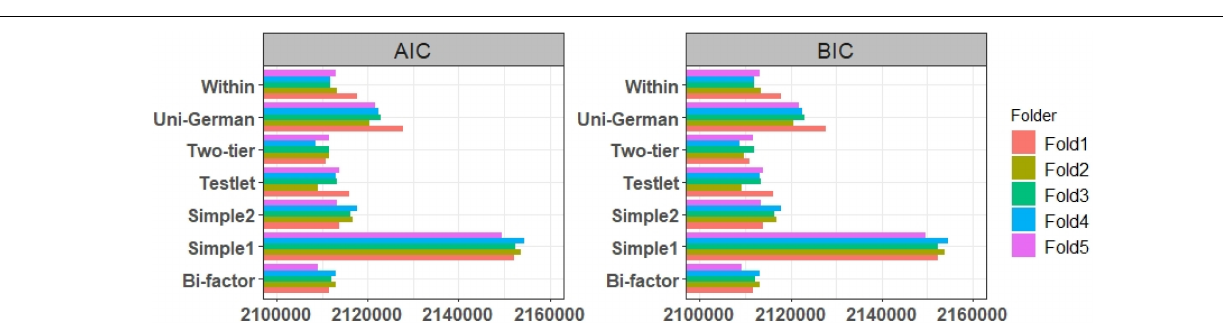
FIGURE 3 | The results of the AIC, BIC values of German test. Simple 1 and Simple 2 show uncorrelated and correlated simple structure, Uni-German shows unidimensional German test, all models were estimated with 2PL